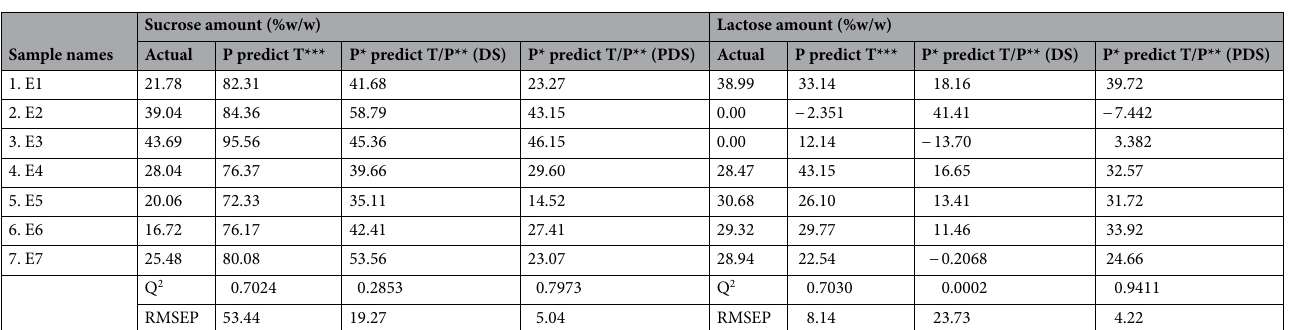
Table 4. Sugar determinations in real milk tablet samples. *P = powder samples, **T/P = tablet samples adjusted to powder samples, ***T = tablet